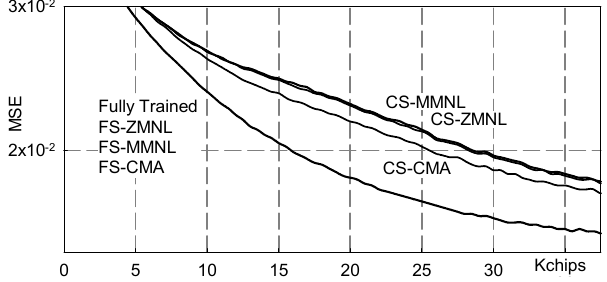
Figure 6. Mean square error (MSE) vs. transmitted chips: channel (11), NSR = 20 dB.